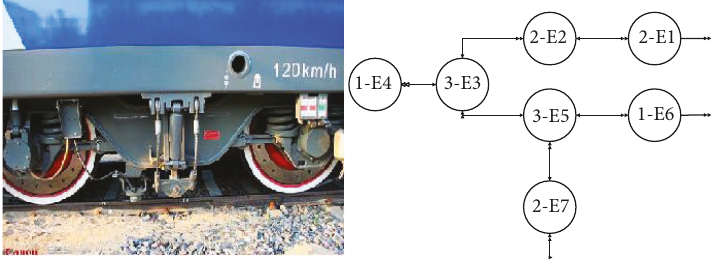
Figure 9: Model of parking brake control device.